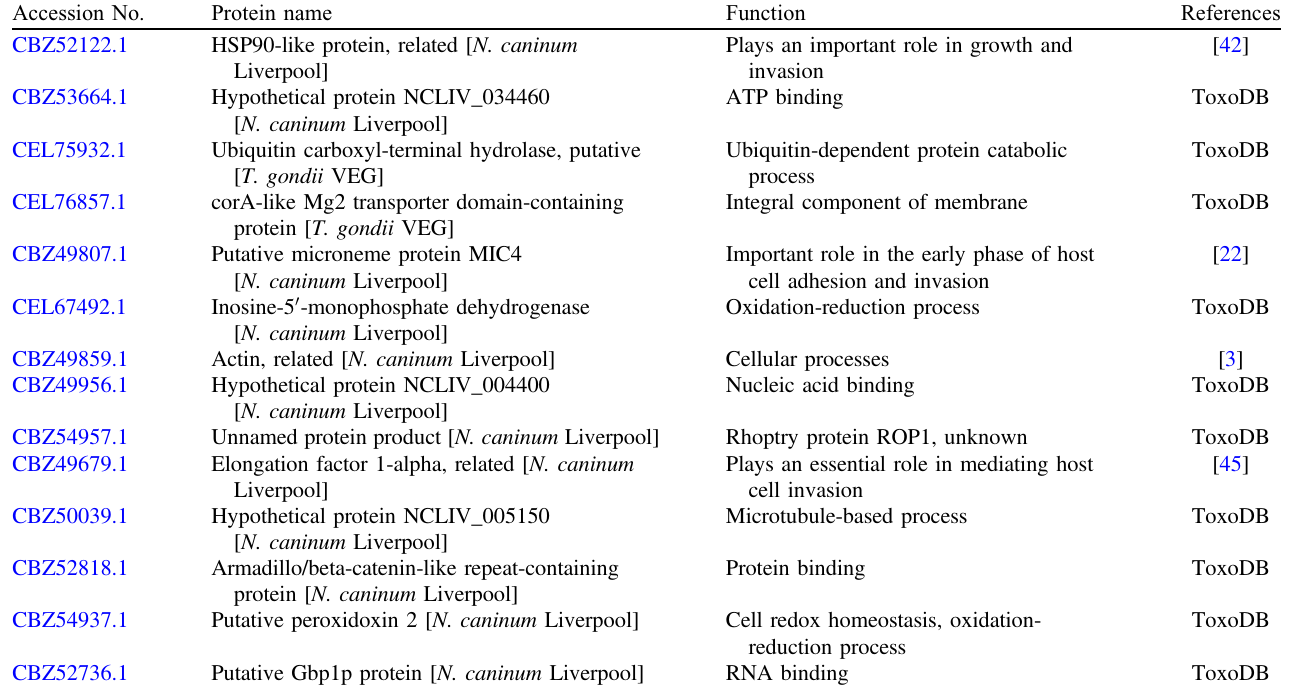
Table 4. Functional classi fi cation of immunoreactive proteins against Neospora caninum. Accession